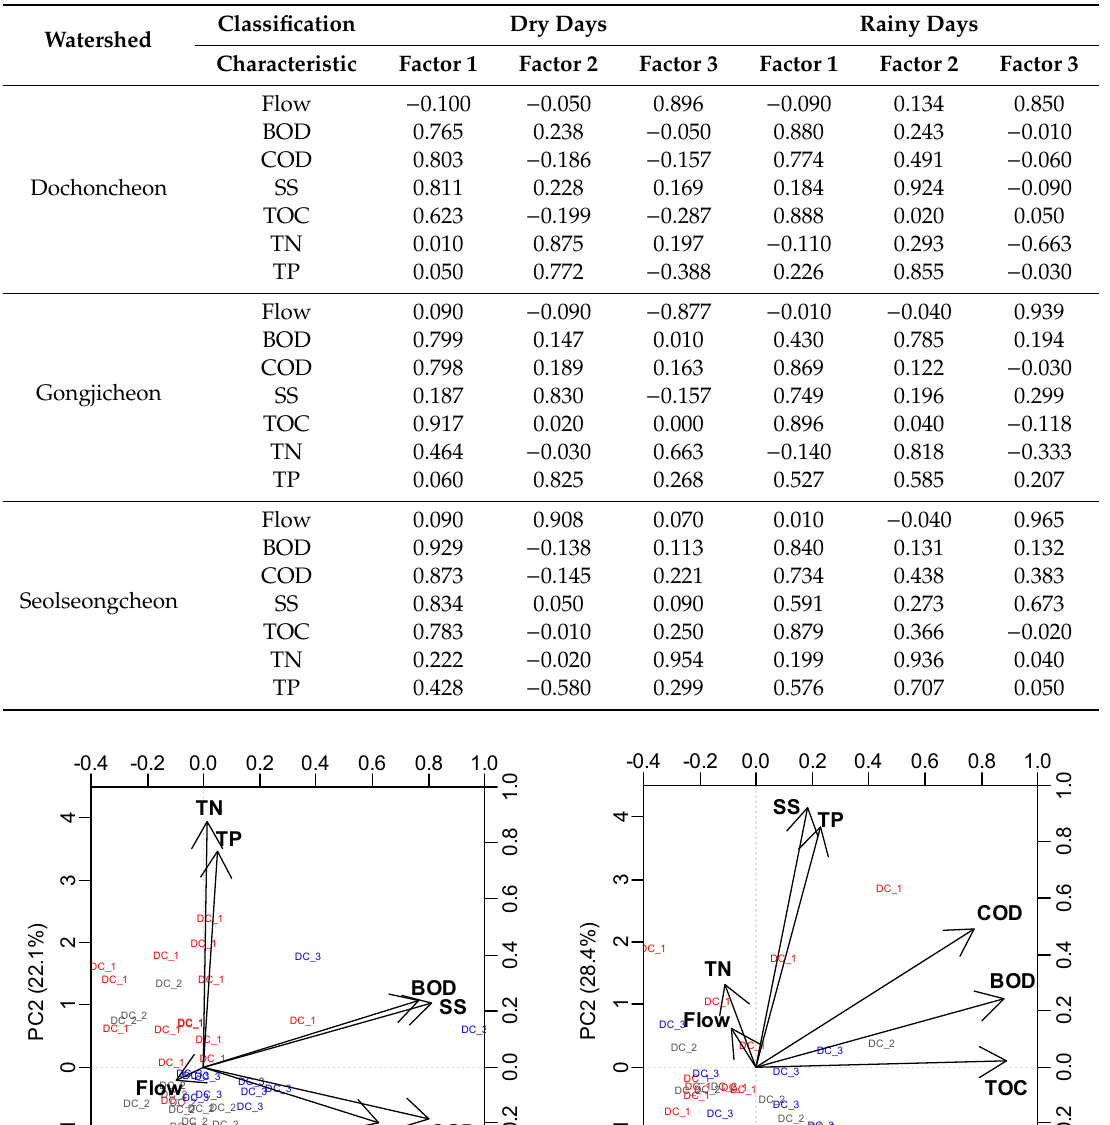
Table 6. Loadings of experimental variables (7) on principal components for three watersheds.